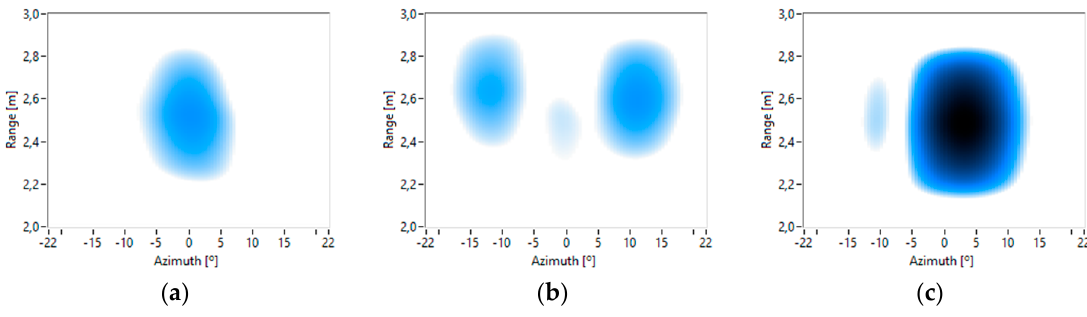
Figure 15. Acoustic images of a person at different elevations: ( a ) 5 ◦ ; ( b ) 0 ◦ ; and ( c ) − 10 ◦ with a constant frequency.